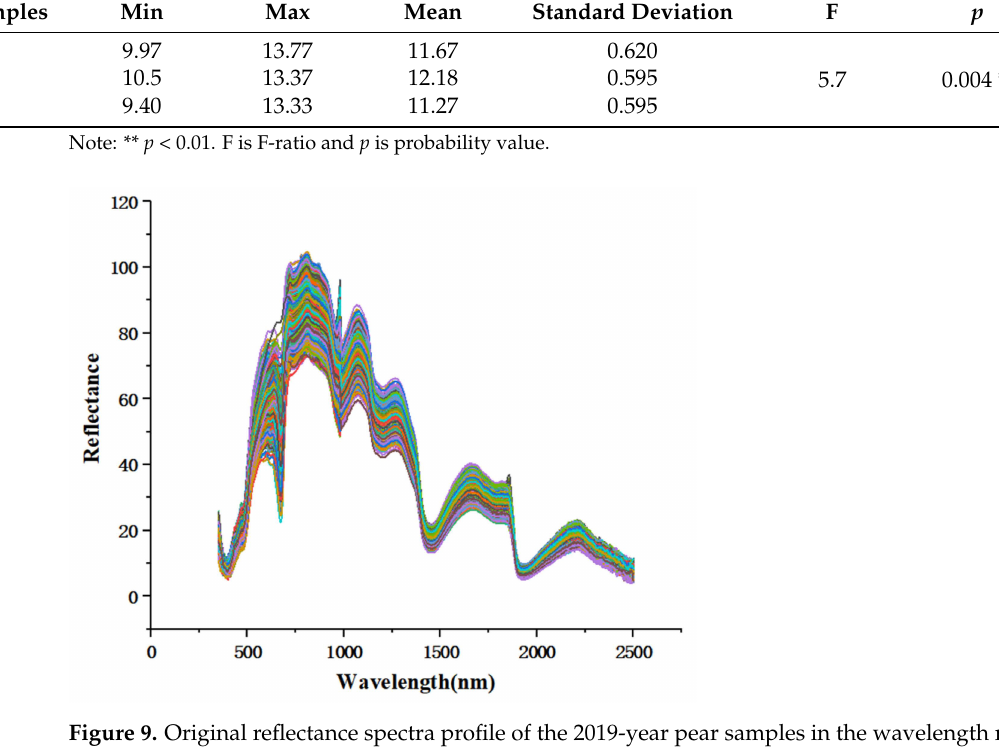
Figure 9. Original reflectance spectra profile of the 2019-year pear samples in the wavelength range of 350–2500